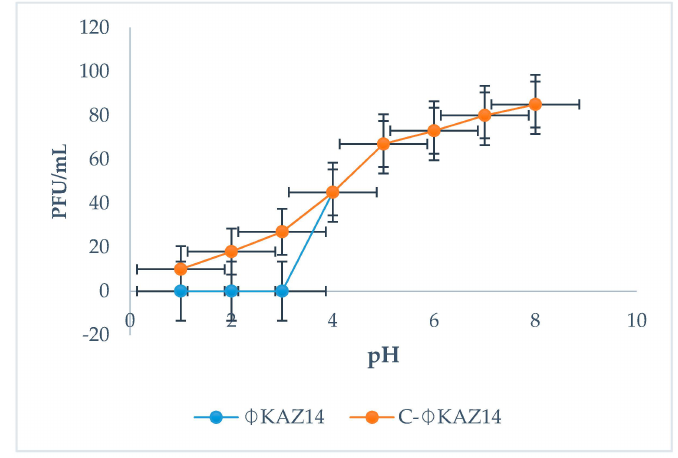
Figure 4. Stability of Φ KAZ14 bacteriophage under different pH